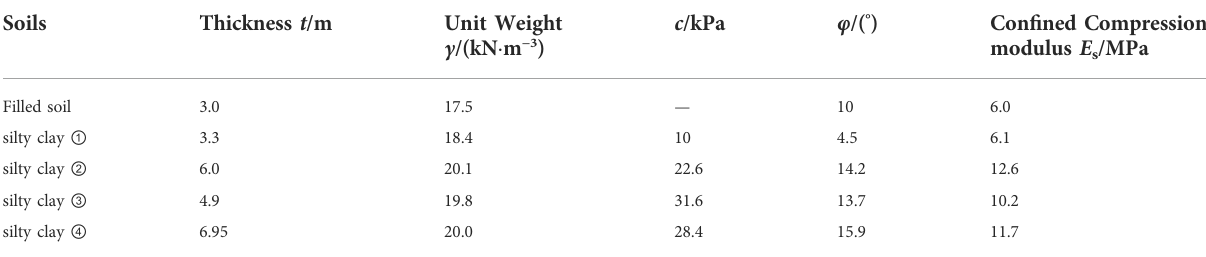
TABLE 1 Mechanical properties of